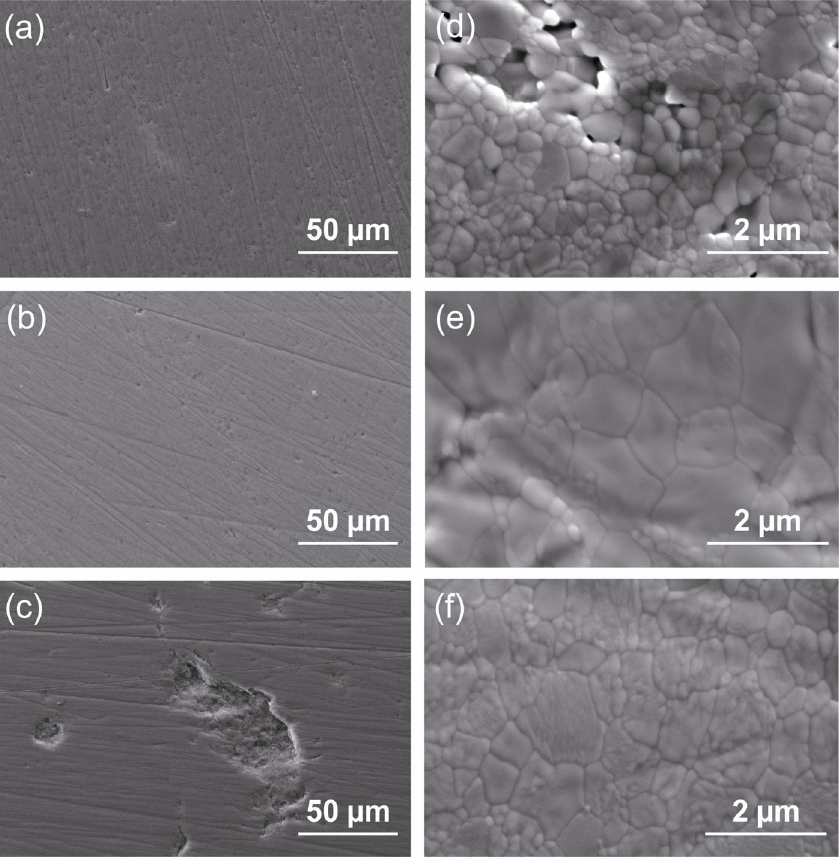
Fig. 7 SEM images showing the surface microstructure of polished YSZ pellets sintered at 1300 ℃ : (a, d) TZ-8Y; (b, e) MELox 8Y; (c, f)